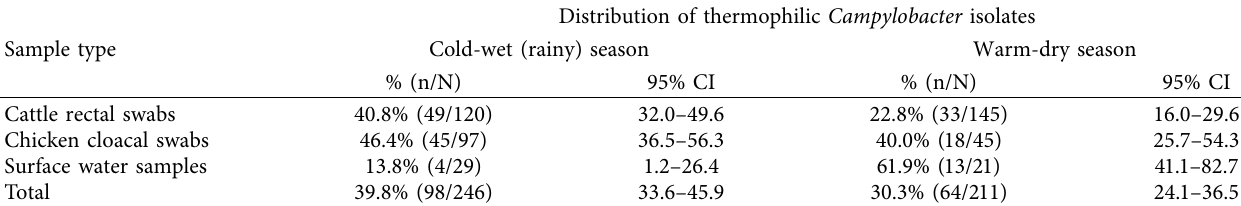
Table 3: Seasonality of thermophilic Campylobacter isolates from different sample types. Sample type